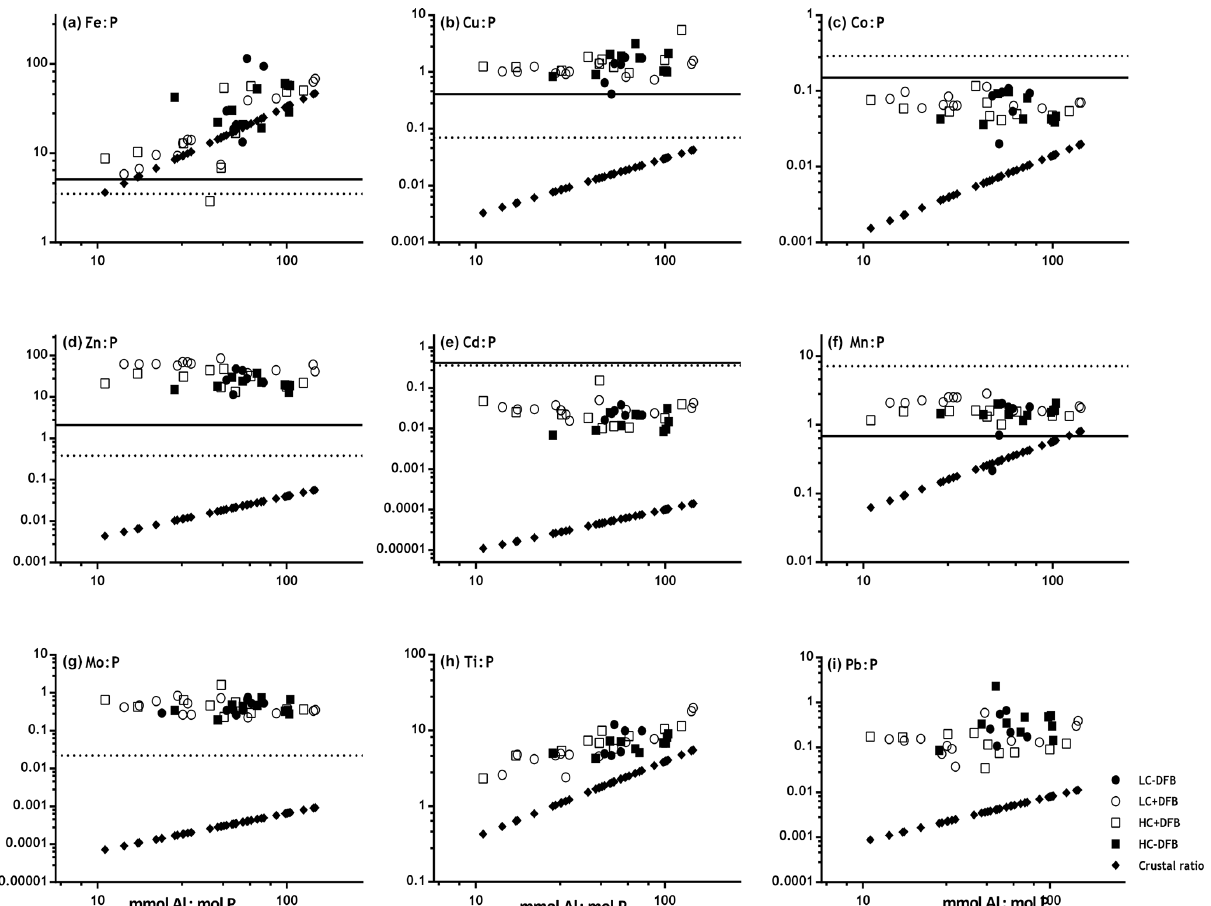
Figure 3. Comparison of P-normalized metal ratios in particles (mmol : molP) against mmol Al : molP ratios in the same particles (without oxalate wash) collected from the different mesocosm treatments (LC: ambient CO 2 ; HC: increased CO 2 (900µatm); -DFB: no DFB addition; +DFB: with a 70nM DFB addition) during the development of a bloom on days 12, 17 and 21 (original data reported in Table S2). The parallel solid and dotted lines on the x axis represent the average metal quotas obtained from marine plankton assemblages (Ho, 2006) and from cultures of Emiliania huxleyi (Ho et al., 2003). The slope of the line with the (cid:7) symbols indicates the average metal:Al (mol : mol) in crustal material (Taylor, 1964). (a) Fe : P, (b) Cu : P, (c) Co : P, (d) Zn : P, (e) Cd : P, (f) Mn : P, (g) Mo : P, (h) Ti : P, (i) Pb :